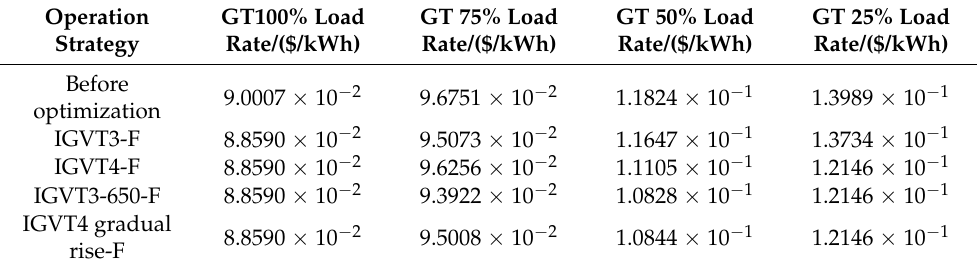
GT 75% Load Rate/($/kWh)